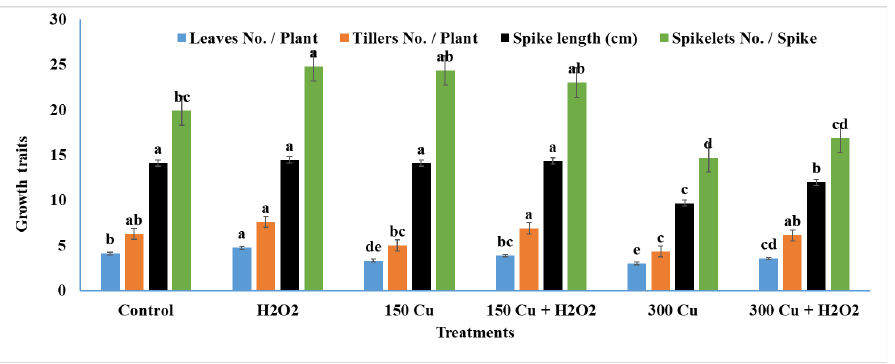
Figure 7. Effect of hydrogen peroxide on growth traits of wheat grown in contaminated sandy soil. Means followed by the same letter in each parameter are not significantly different according to the least significant differences (LSD) test ( p ≤ 0.05). Error bars are ± Standard Error (SE).